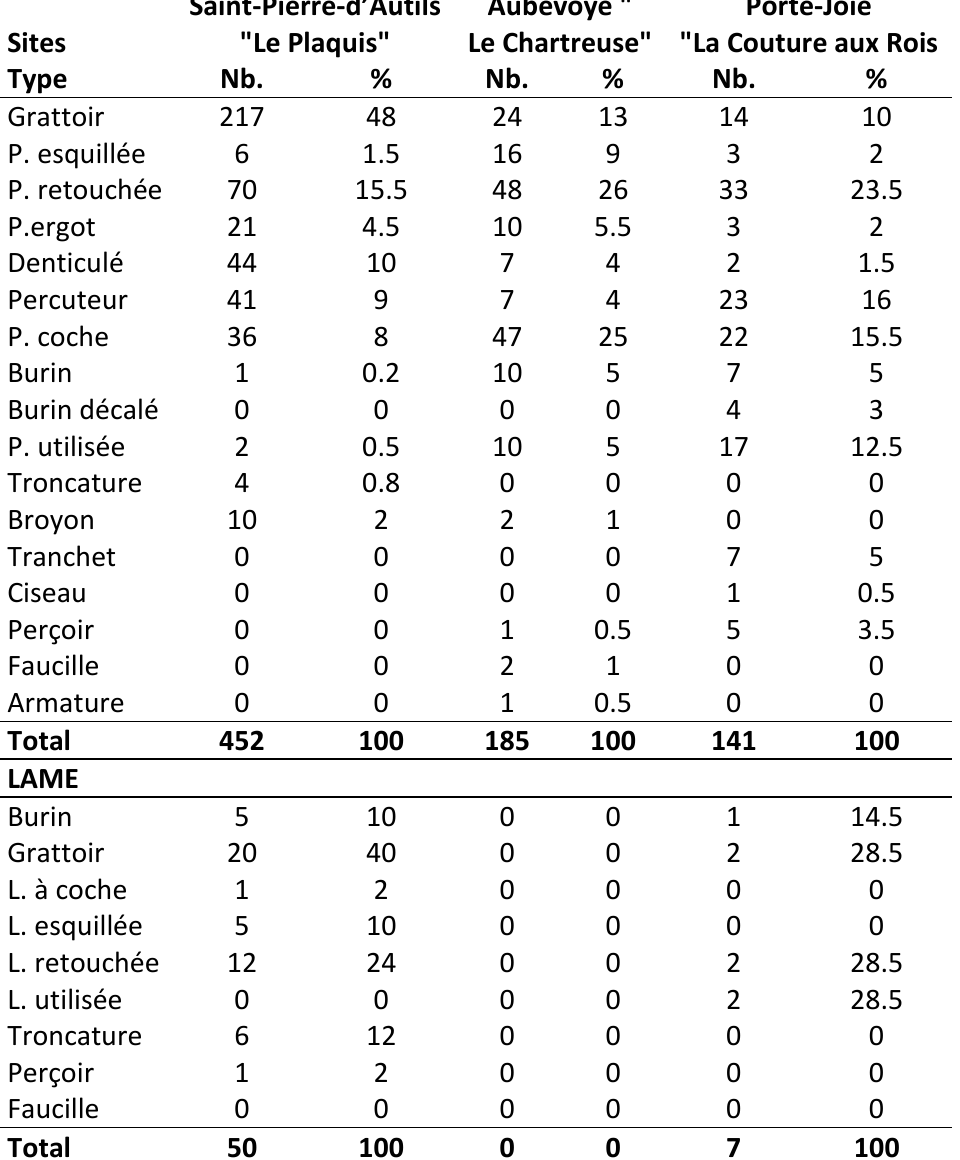
Tableau 3. Décompte des catégories d’outils. Abbreviations: P – Pièces; L - Lame. Table 3. Count of tool categories. Abbreviations: P – Pièces; L -